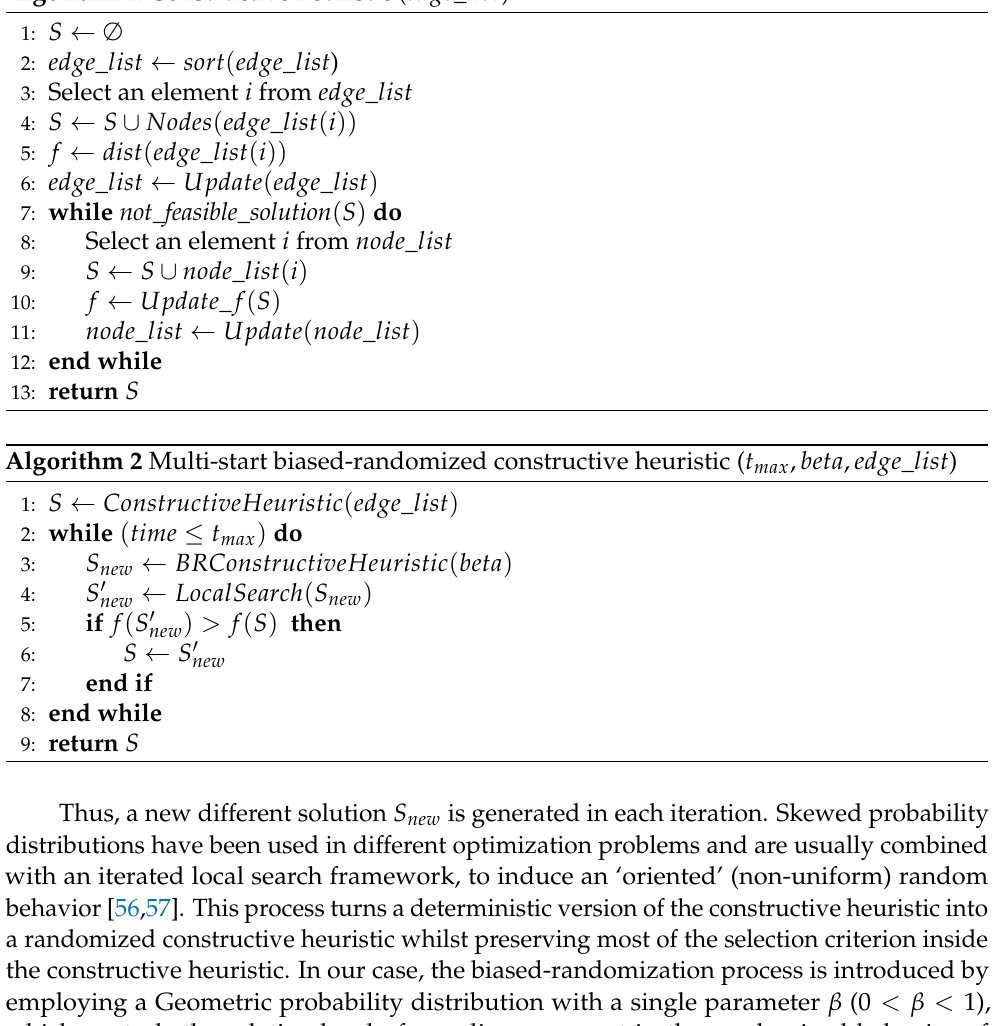
Algorithm 1 Constructive heuristic ( edge _ list )